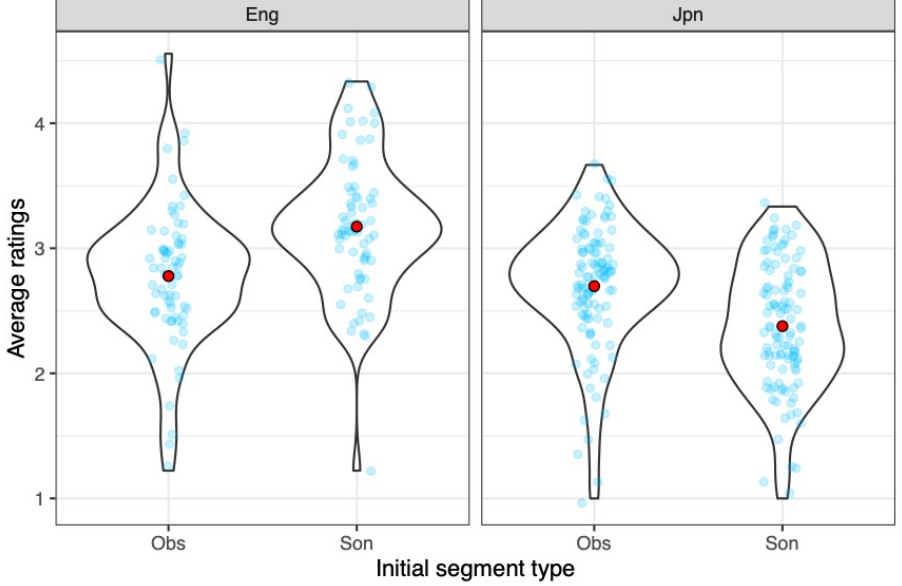
Figure 1. The results of Experiment 1. The x-axis labels are the type of initial segments. The plots are violin plots showing the probability distributions of the averaged responses from each speaker. Each transparent blue dot represents an average response from each speaker. The solid red dots represent the grand averages.